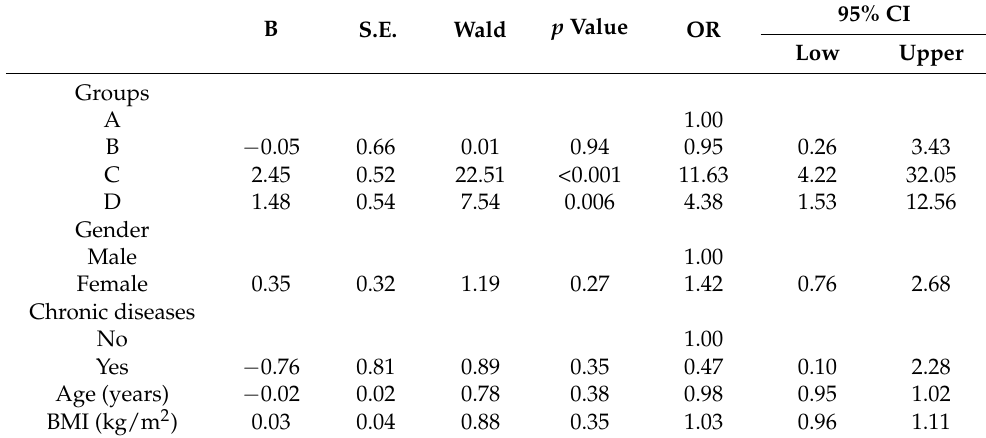
Table 2. Odds ratio for risk of adverse reactions after a vaccine booster.